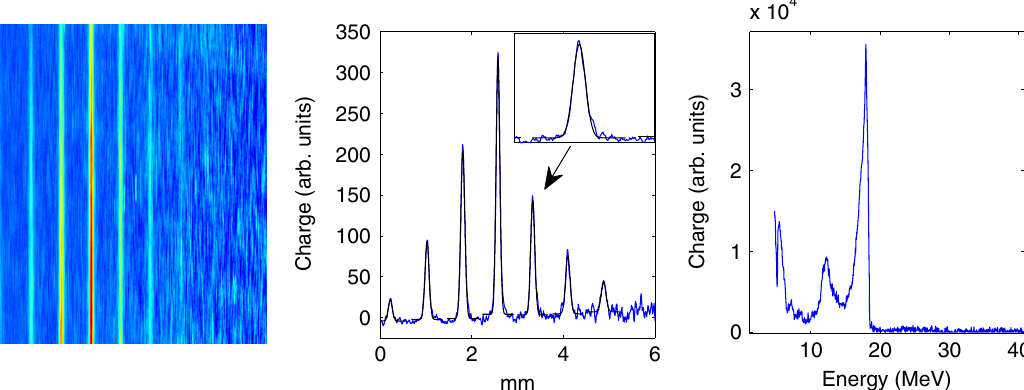
FIG. 2. Example data from the emittance diagnostic. The measured normalized rms emittance for this shot is 1 : 6 (cid:3) 0 : 18 (cid:2) mm mrad . Left: False color image at the emittance diagnostic phosphor showing the vertically stripped beamlets. Right: Vertically summed intensity across the horizontal field of view along with Gaussian fits to each beamlet. The inset shows the fit to a single peak. The mean energy for this shot was 17